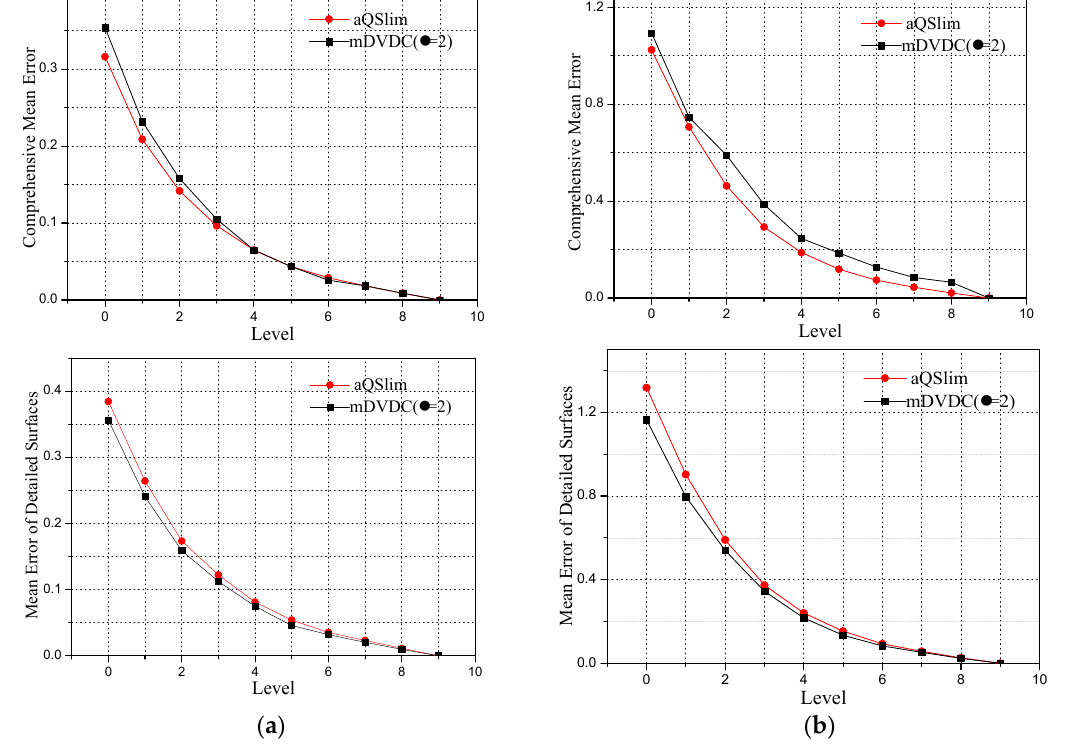
Figure 16. Error measurement and comparison of the modified simplification algorithm. Given the weakness of Metro pointed out above, the mean errors of all surfaces and detailed surfaces are not consistent. A better property in terms of the error of detailed surfaces proves that mDVDC ( λ = 2) better preserves details, which is the core target of surface simplification. ( a ) Scenery 1; ( b ) Scenery 2.